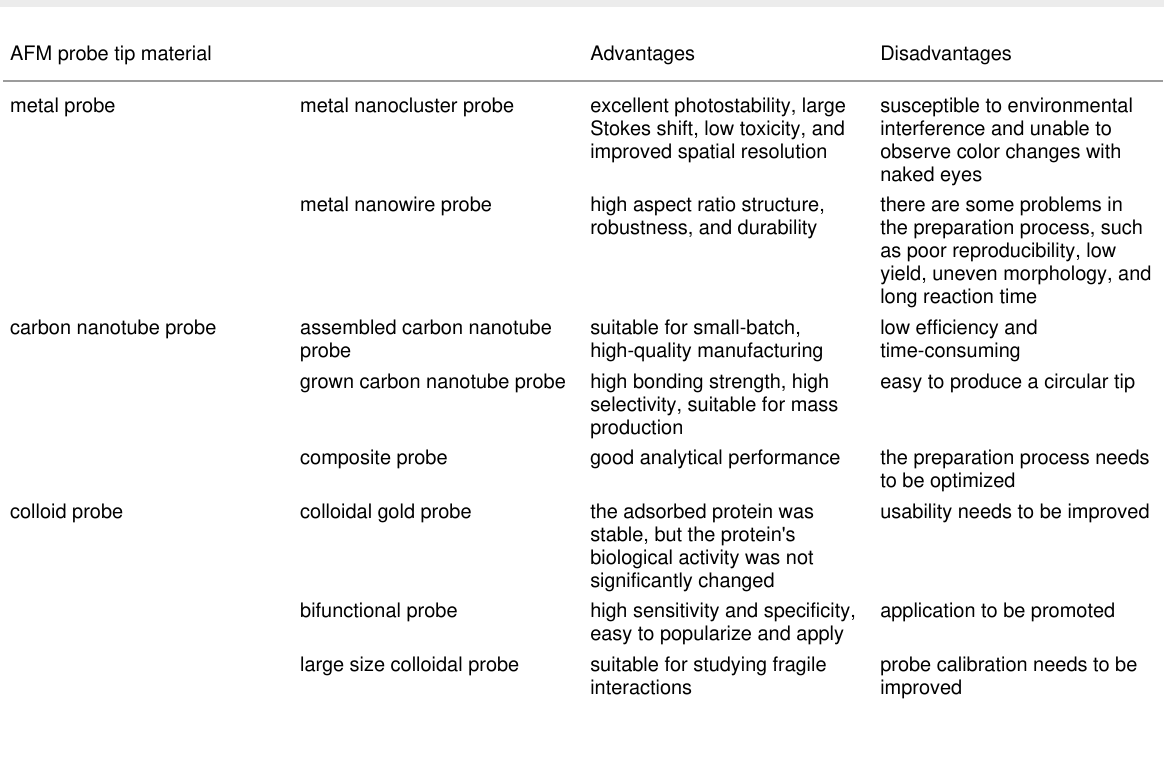
Table 1: Comparison of probe tip